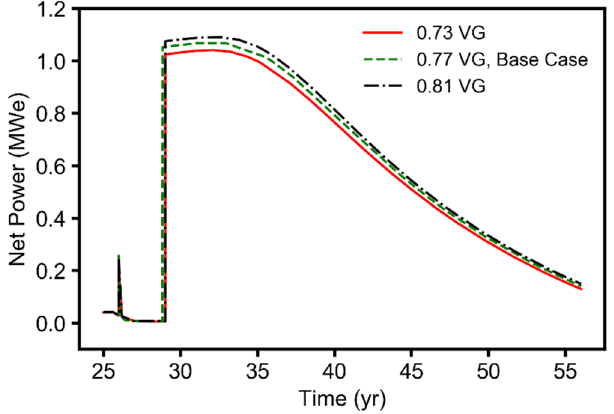
Figure A5. Simulation results (time-series plots) for the relative permeability (van Genuchten) pa- rameter, showing the geothermal net power generated during the EGR and CPG stages (25–55 years).